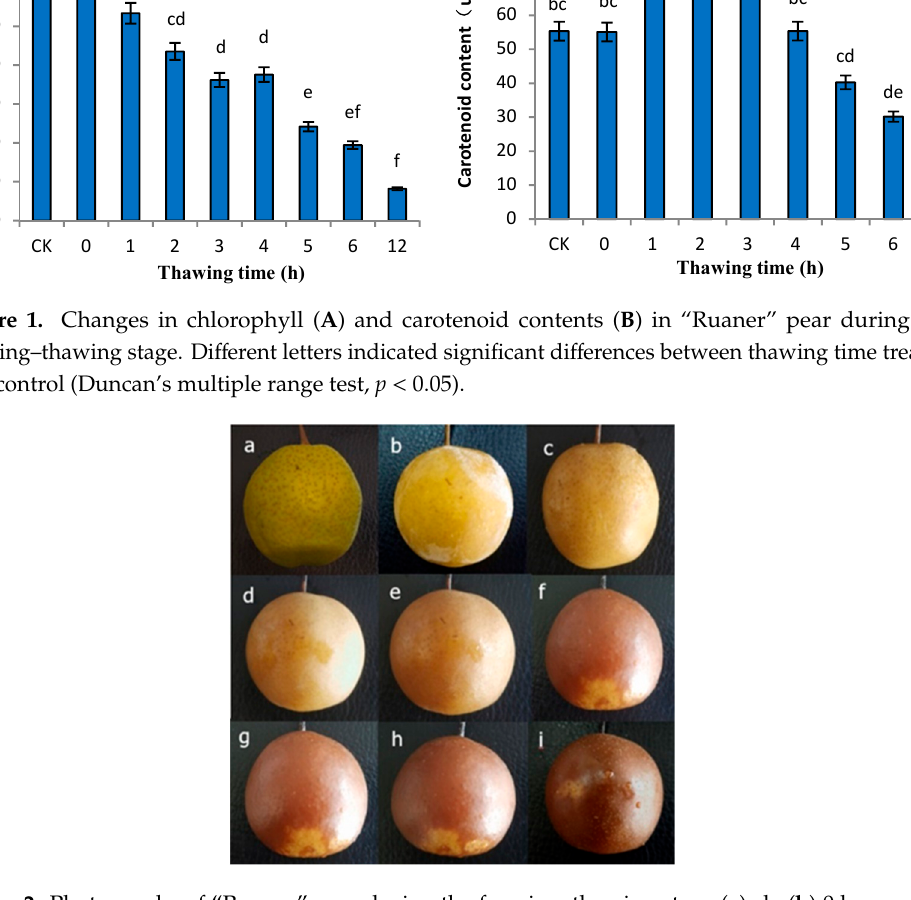
Figure 2. Photographs of “Ruaner” pear during the freezing–thawing stage ( a ) ck, ( b ) 0 hours after thawing (HAT), ( c ) 1 HAT, ( d ) 2 HAT, ( e ) 3 HAT, ( f ) 4 HAT, ( g ) 5 HAT, ( h ) 6 HAT, ( i ) 12 HAT.